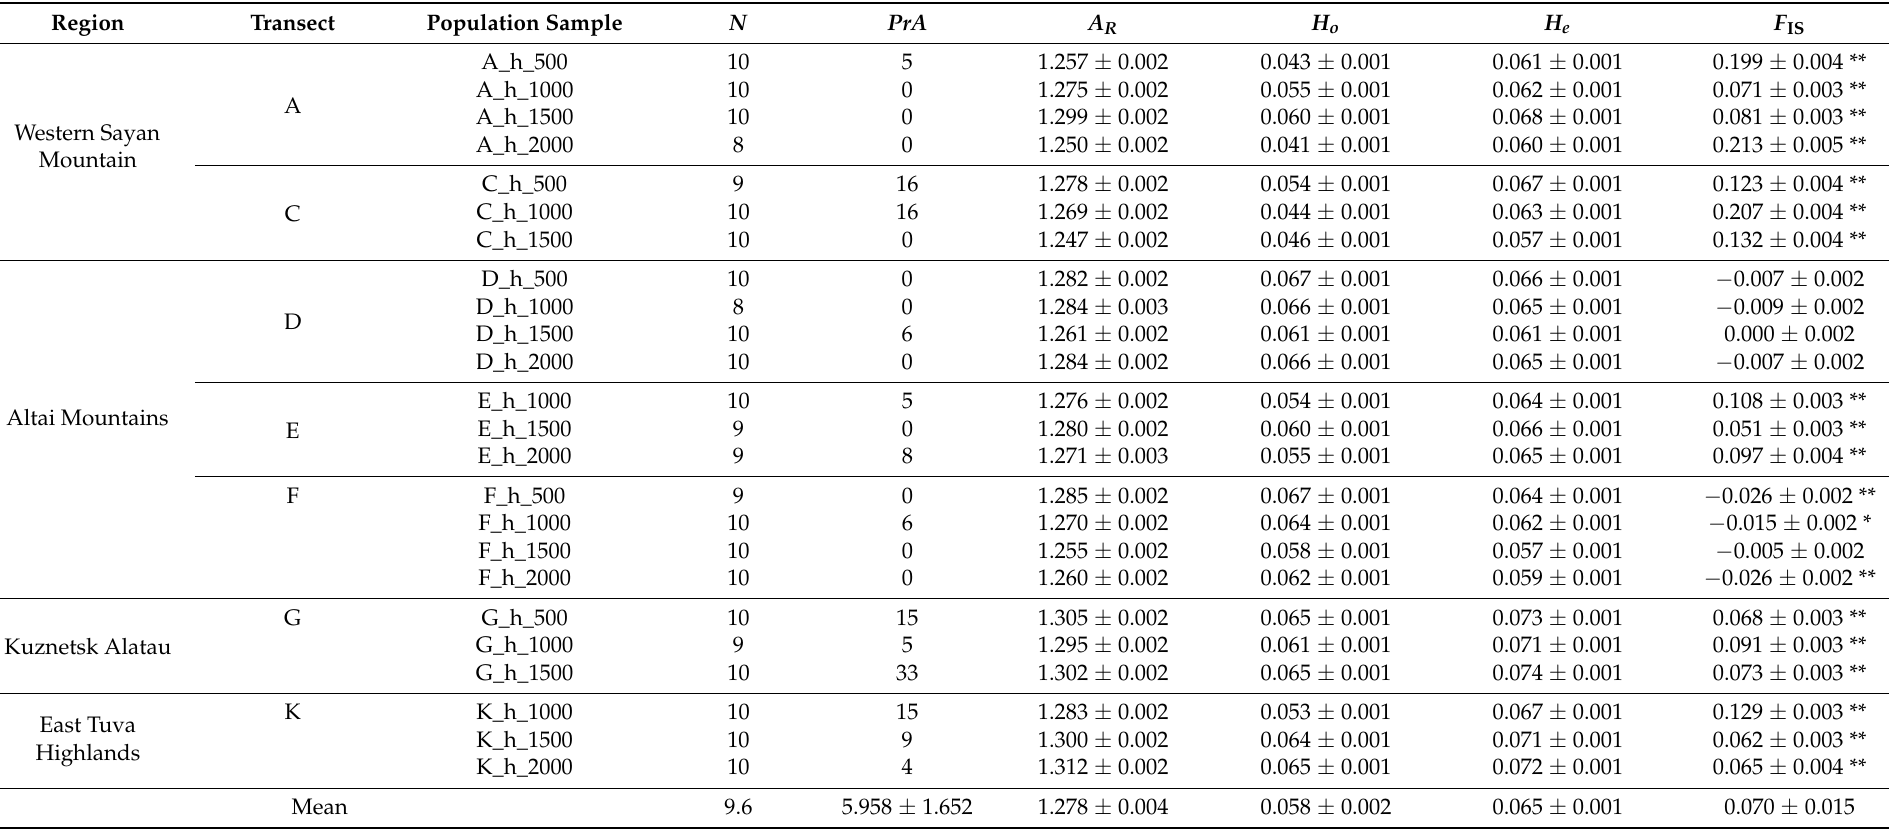
Table 3. The summary of genetic variation parameters ± SE based on 25,143 SNPs for each of the 24 population samples of Siberian larch.